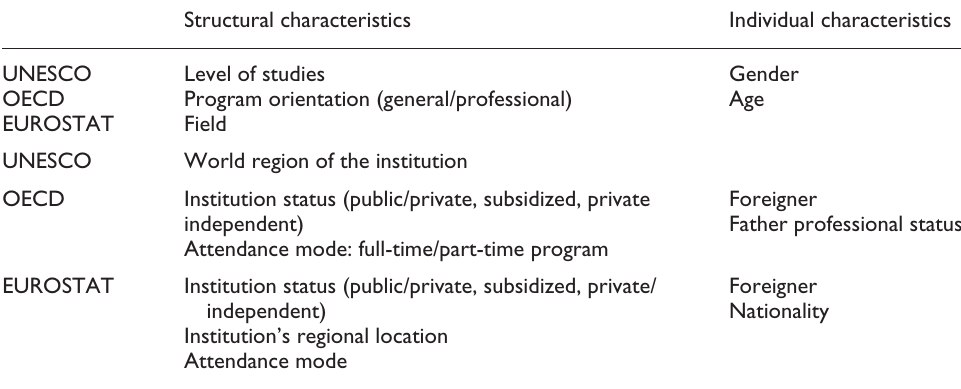
Table 1. Comparative framework of inequalities indicators regarding access to higher education for UNESCO, OECD and EUROSTAT. Structural